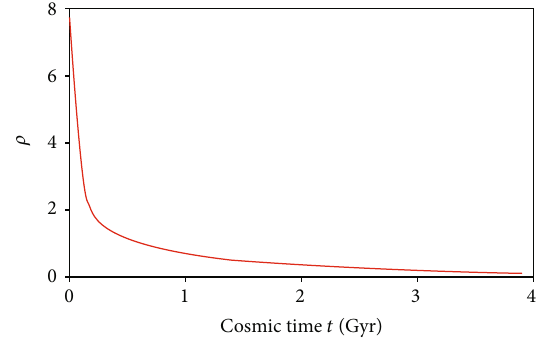
= 1 , respectively. 0